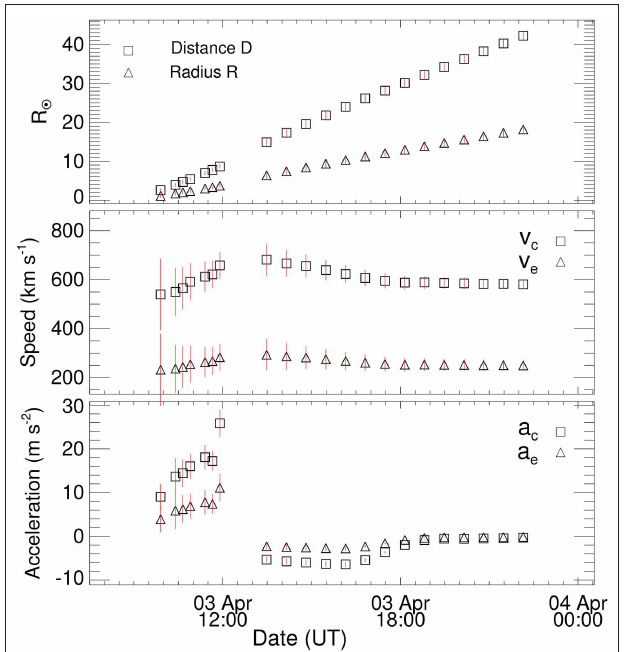
FIGURE 4 | The top panel shows the variations of the heliocentric distance ( D ) of the center of flux rope CME and its radius ( R ) with time. The data points before and after the measurements gap correspond to estimates from the COR2 and HI1 observations, respectively. The first-order derivative of D and R as the propagation speed ( v c ) and expansion speed ( v e ) is shown in the middle panel. The bottom panel shows the propagation acceleration ( a c ) and expansion acceleration ( a e ) as the first-order derivative of v c and v e , respectively. The vertical lines at each data point show the error bars which are derived from the arbitrary assumption of the uncertainties of 0.5 R ⊙ and 1 R ⊙ in the measurements of D from COR2 and HI1 observations, respectively.